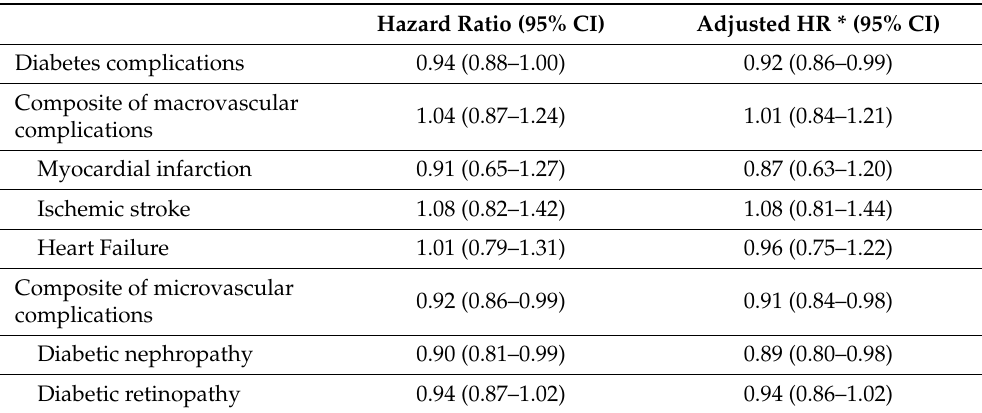
Table 4. Cox proportional hazards model of the association between a decreasing HbA1c and diabetes complications ( n =